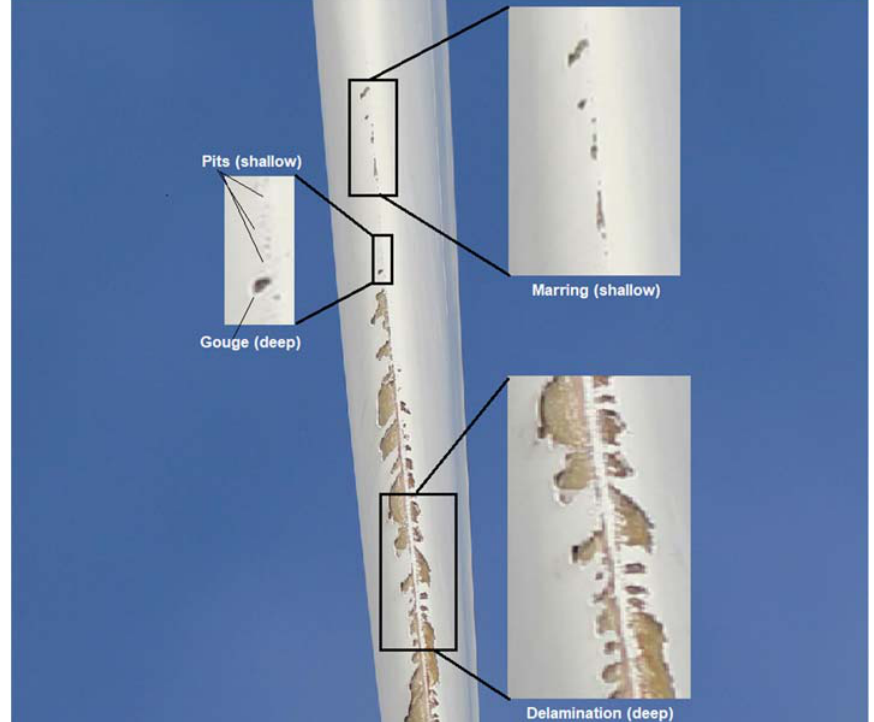
Figure 1. Example of a fi eld image containing extensive LEE of varying severity. All damage in the dataset is classi fi ed as either deep (delamination/gouges—continuous/concentrated damage that removes the outer laminate layer, revealing internal material) or shallow (pits/marring—concentrated/continuous damage to the laminate layer that does not reveal internal material).